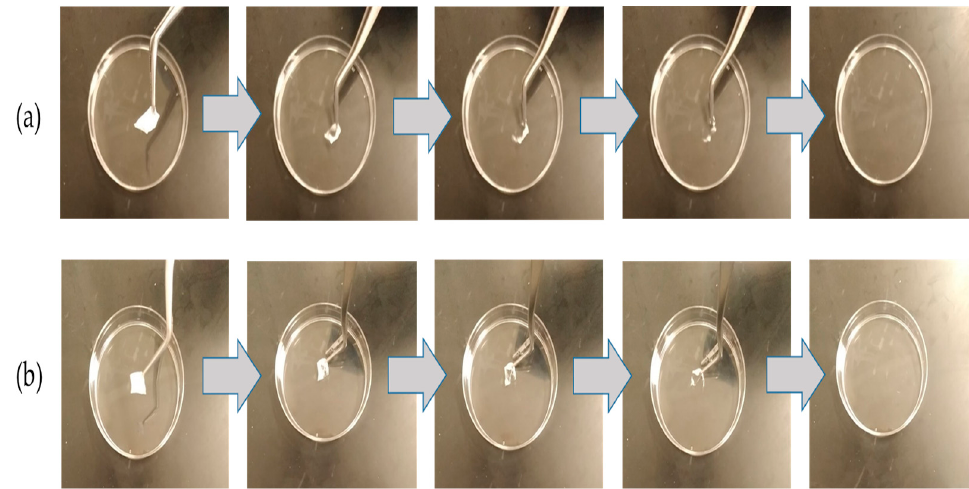
Figure 3. The disintegration of ( a ) blank nanofibers and ( b ) imeglimin-loaded nanofibers demon- strates that both nanofibrous systems dissolved ultra-rapidly ( ≤ 2 ± 1 s, n = 3).